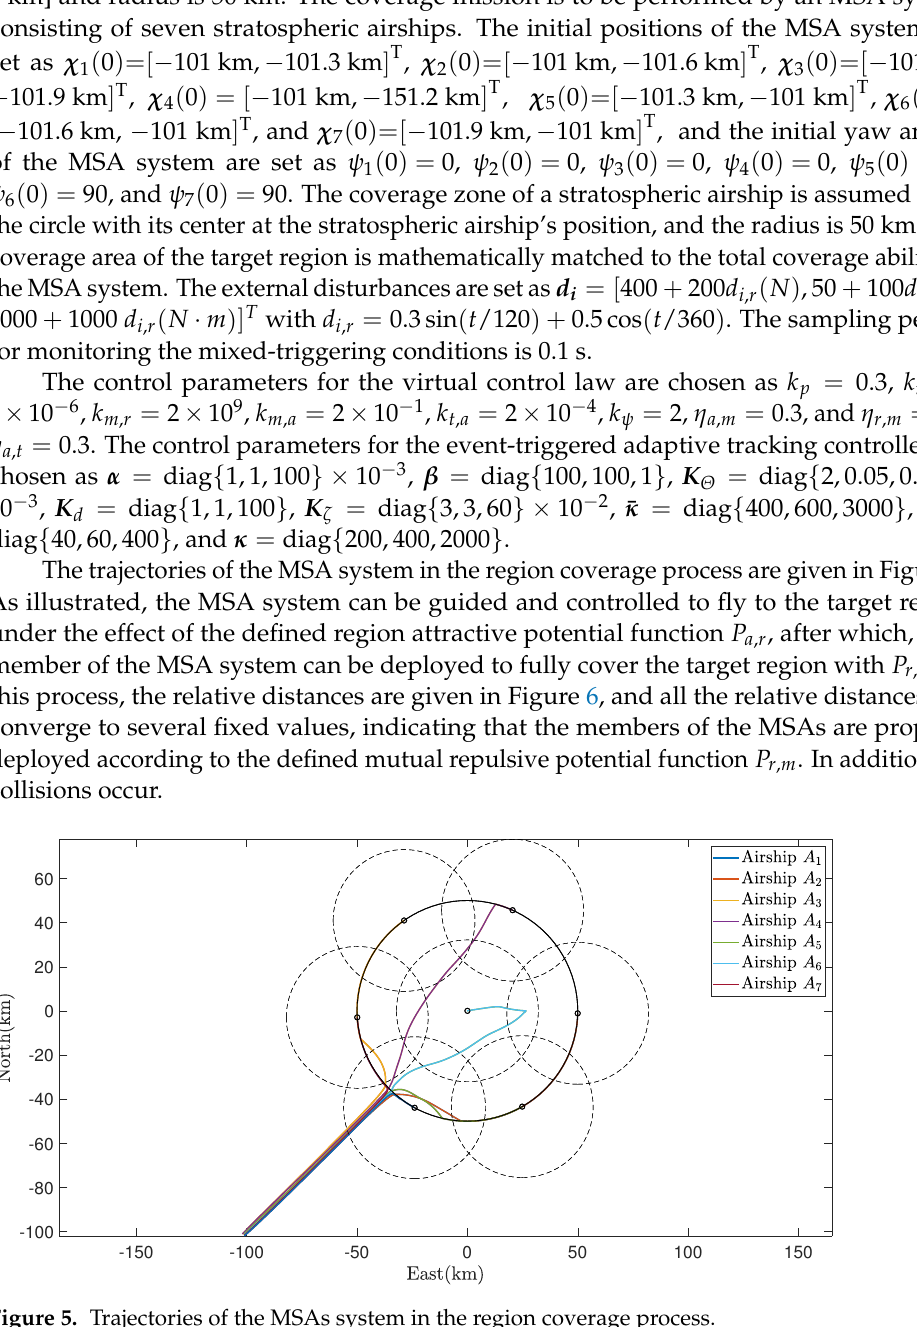
Figure 5. Trajectories of the MSAs system in the region coverage